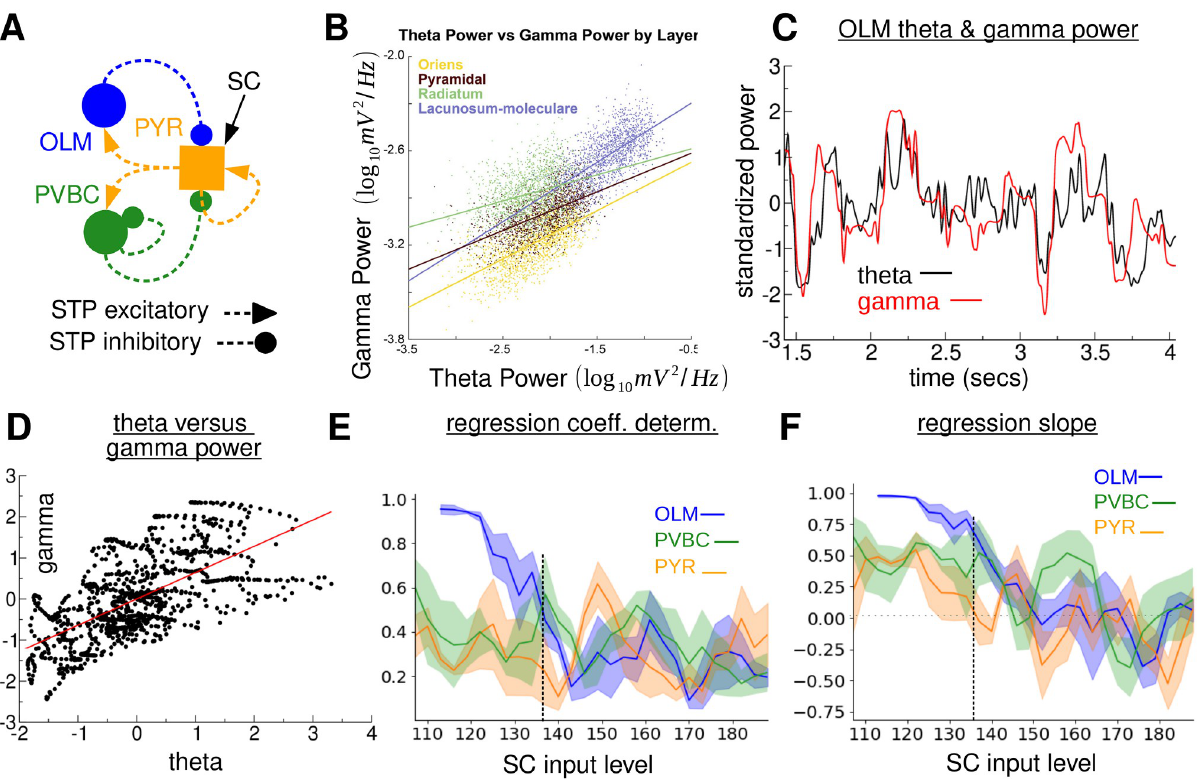
Fig 8. Theta and gamma power strongly covary in the 480 PYR, 20 OLM, 20 PVBC full model with facilitating/suppressing connections investigated in Figs 2 and 3. (A) Circuit schema . (B) Empirical comparison. Scatter plot and least-squared regression lines for theta and gamma power across the layers of a rat. There is a clear positive trend across all layers, although it is strongest in the lacunosum-moleculare. Reproduced from [57]. (C) Time development of standardized theta (black) and gamma (red) power in a one second window centered on the plotted time point for the simulation described in Fig 2. Theta power is calculated in a 4 Hz band centered on the peak theta frequency (4.5 Hz) and gamma power in a 16 Hz band centered on the peak slow gamma frequency (25 Hz). Both time series are standardized . D Illustration of standardized theta power plotted against standardized gamma power (black) for the results in C and linear regression (red) . (E,F) Coefficient of determination E and slope F for linear regression of theta against gamma power for many microcircuit simulations at different levels of SC driving for the three cell populations. Error bands show SEM over two network simulations with identical parameters. Vertical dashed line indicates simulation in (b-d) at SCIL 136